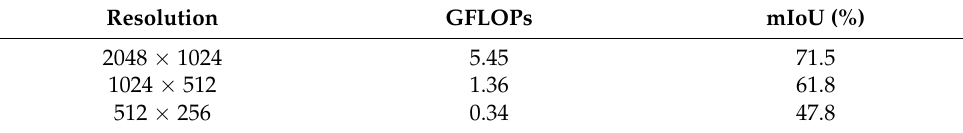
Table 7. Results of various resolution inputs on the Cityscape validation